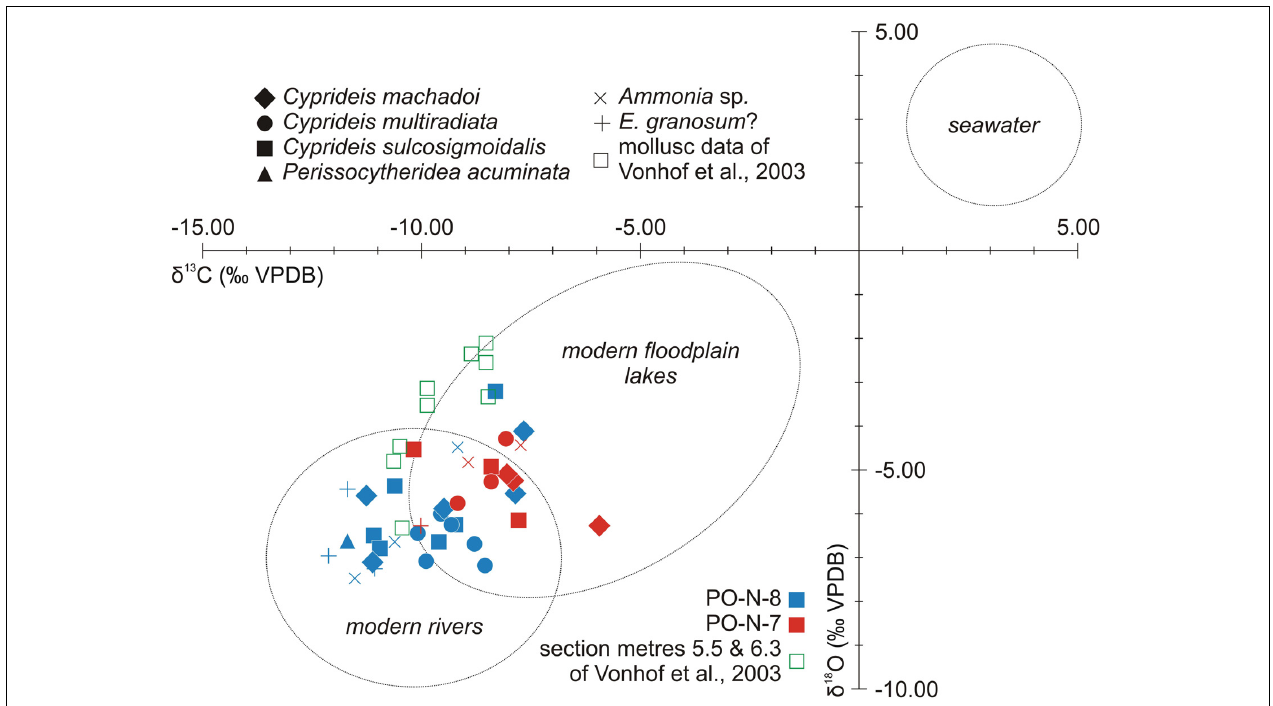
FIGURE 5 | δ 18 O- and δ 13 C-isotopic ratios of foraminiferan tests, ostracod valves, and mollusk shells from Porvenir (for data, see Table 1 ). Ellipses indicate the range of modern Amazonian river and floodplain lake dwelling mollusks (modified from Wesselingh et al., 2006b; note: mollusk aragonite furnish slightly heavier ratios than ostracod calcite within the same environment; Grossman and Ku, 1986).